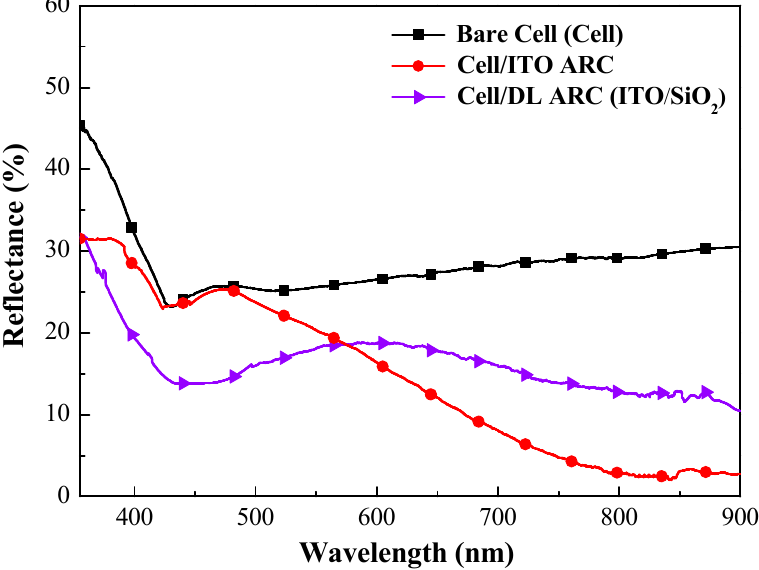
Figure 7. Optical reflectance spectra of bare-type GaAs single-junction solar cells and GaAs solar cells coated with layer of ITO or ITO/SiO 2 .